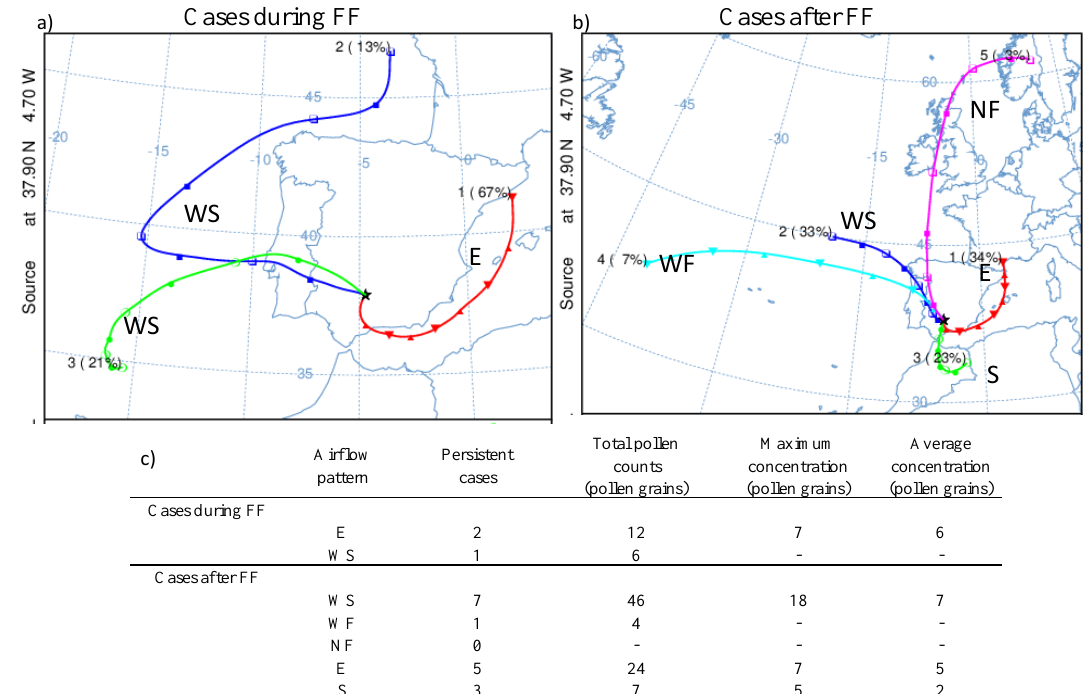
Figure 4. Average cluster results (centroids) in Cordoba at 100 m ( a ) on dates during full flowering (FF) and ( b ) after FF of Castanea pollen (Table 1). In both, the numbers on the right in the centroids are the percentage of complete trajectories occurring in that cluster, and the numbers on the left are an identification number of the centroid. ( c ) Castanea pollen concentrations statistics by persistent cases within and after FF.